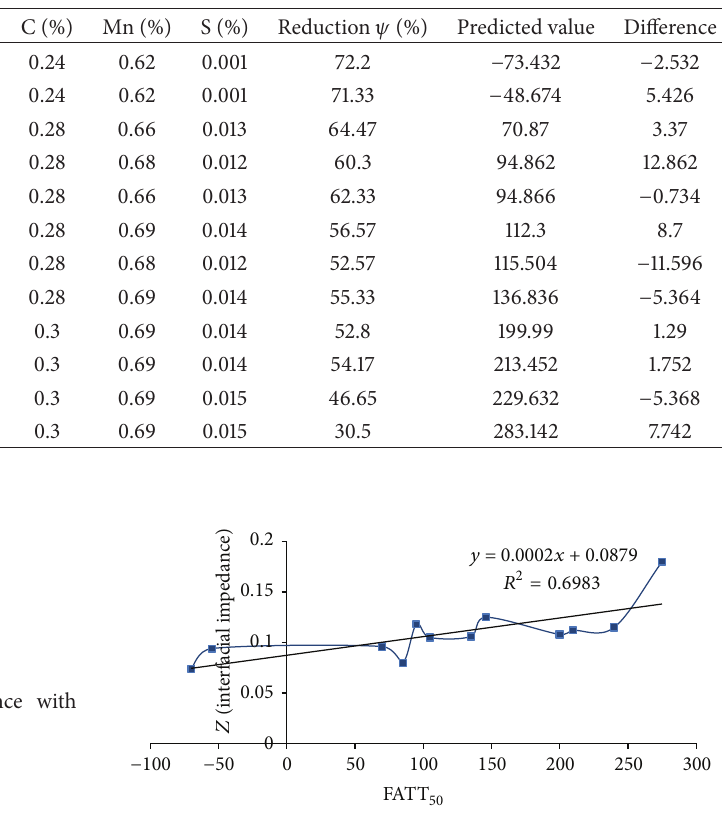
Figure 2: Nyquist diagrams of the impedance of different samples. -related parameters. Table 3: FATT 50